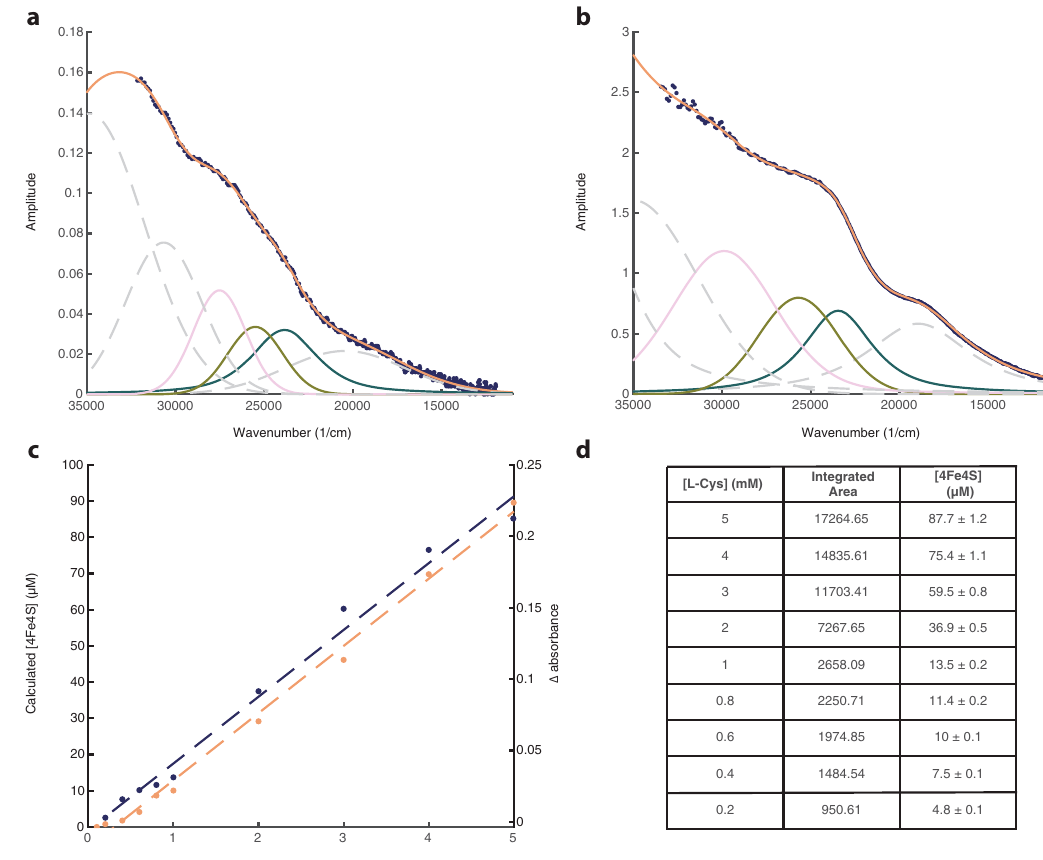
Fig. 2 UV-Vis spectra of [4Fe4S] 2 + clusters, with curve fi tting based on ligand-metal charge-transfer excitations. a Curve- fi tting based on the method of Galambas et al. (see ‘ Methods ’ ) recorded over the 35,000 – 10,000cm − 1 (285 – 1000 nm) spectral range for 0.2 mM L-Cys, with Fe 3 + and S 2 − in a 5:1:1 ratio. We fi tted the three lowest-energy ligand-to-metal charge transfers (LMCT) for [4Fe4S] 2 + : peak 3 (pink) is a high-energy LMCT band associated with thiolate S → Fe, while peaks 4 and 5 (green and blue) are intermediate energy LMCT bands associated with sul fi des → Fe. b . Curve fi tting for 5 mM L- Cys, with Fe 3 + and S 2 − in a 5:1:1 ratio. c Calculated concentration of [4Fe4S] 2 + clusters ( µ M) versus cysteine concentration (mM) based on integrated curve area (black), compared with a three-point method (brown, Δ absorbance; see text). d Table of data including calculated uncertainties based on reference [4Fe4S] 2 + concentrations from Galambas et al. 30 . For panels a and b , each peak corresponds to a speci fi c excitation (from left to right: peak 1 grey dashed line — peptide charge-transfer; peak 2 grey dashed line — thiolate RS − ⟶ Fe; peak 3 pink line — thiolate RS − ⟶ Fe; peak 4 green line — S 2 − ⟶ Fe; peak 5 blue line — S 2 − ⟶ Fe; peak 6 grey dashed line — ligand fi eld). Source data are provided as a Source data fi